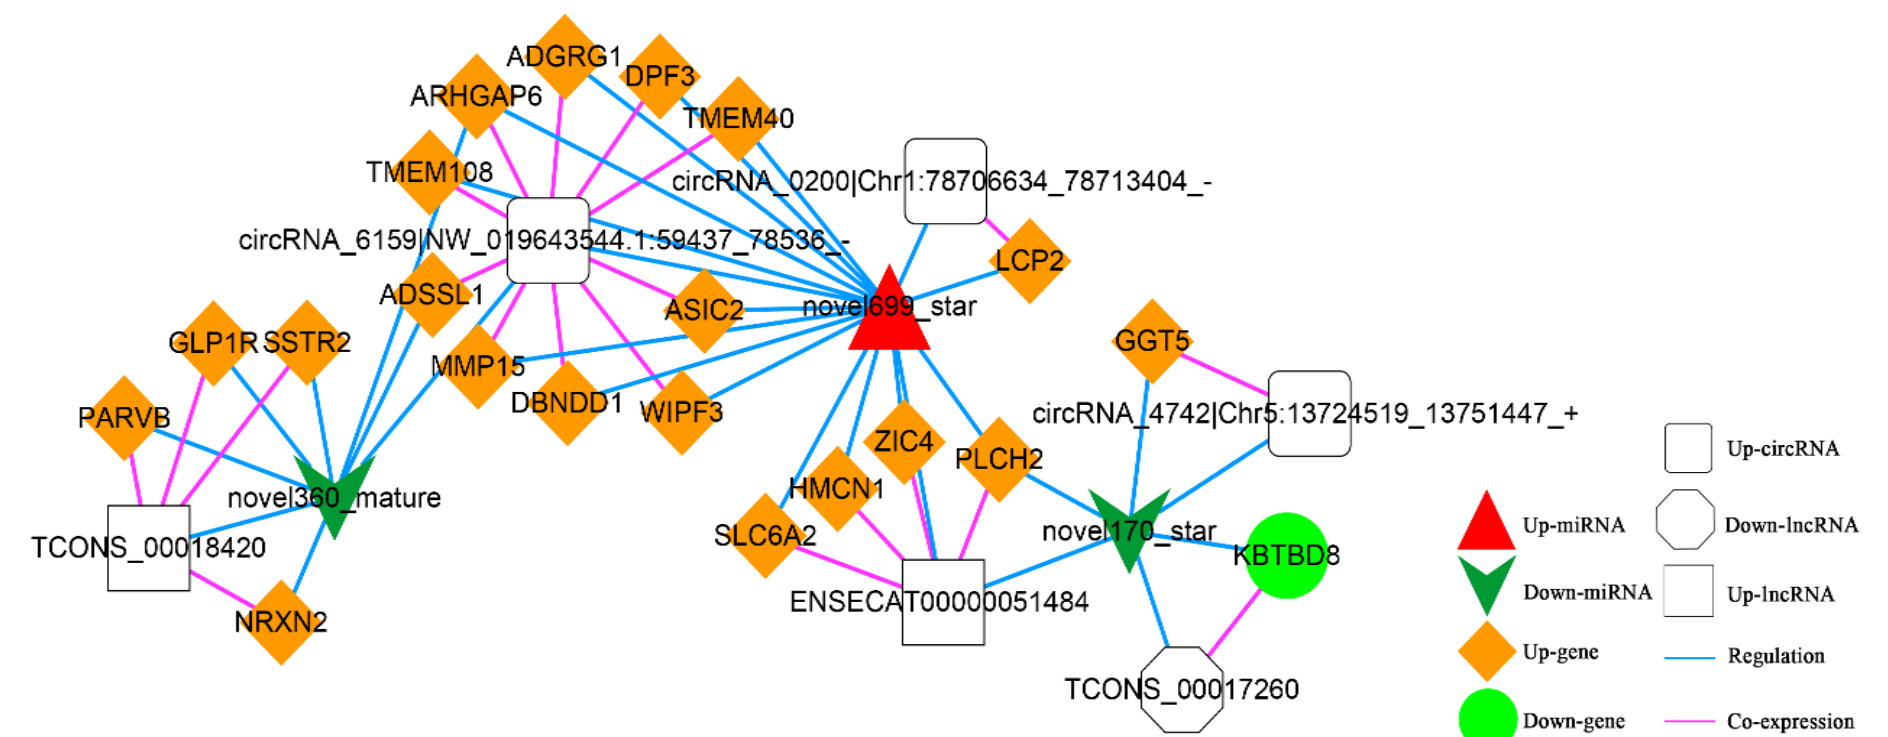
Figure 13. The Competing Endogenous RNA (ceRNA) Network. Orange diamond and green ellipse represent the up-regulated and down-regulated genes, respectively; white rectangle, round rectangle and octagon show the up-regulated lncRNA and circRNA, down-regulated lncRNA, respectively; red triangle and green V indicate the up-regulated and down-regulated miRNA, respectively. The pink and blue line represents the co-expression and regulatory relationship, respectively.